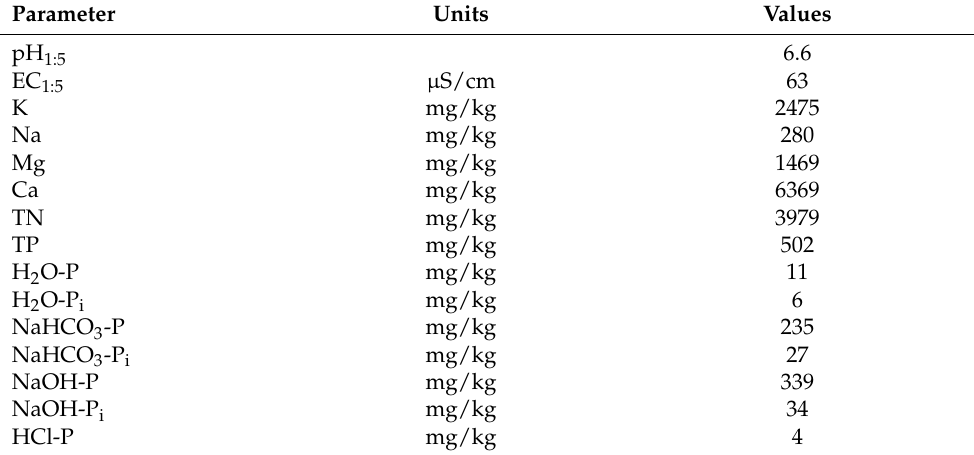
Table 1. Characteristics of soil used for pot studies.